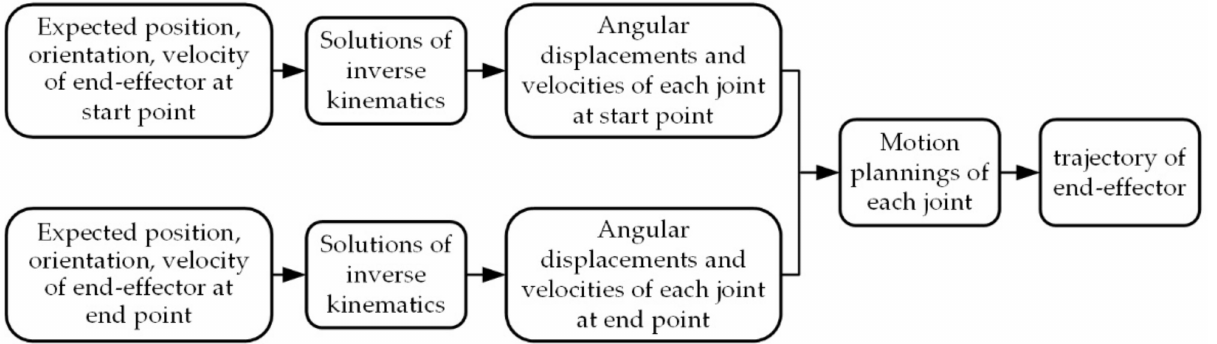
Figure 2. Relationship between PTP end-effector motion and PTP motion plannings of